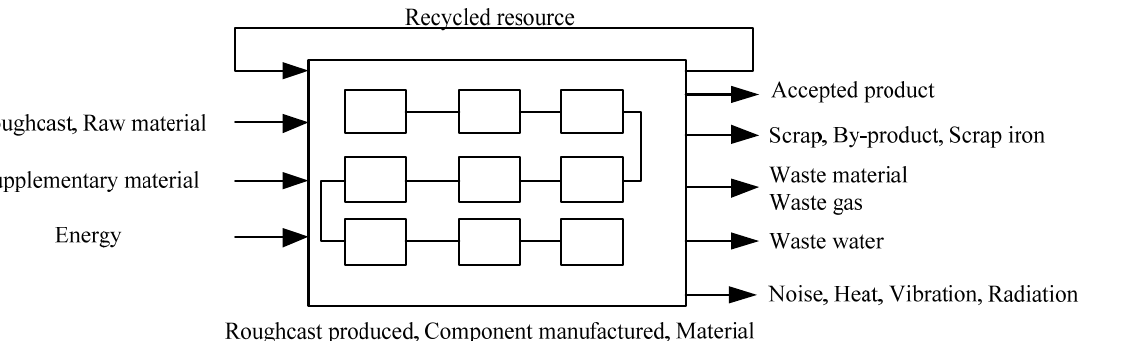
Figure 1. Product manufacturing process resource-environment input and output